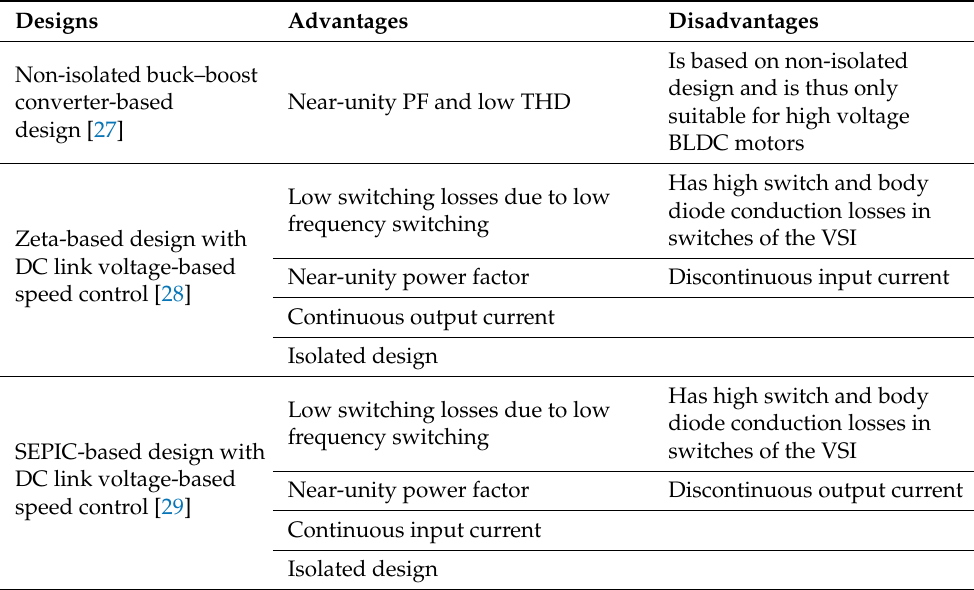
Table 3. Techniques of BLDC ceiling fan supply and control design as per the recent